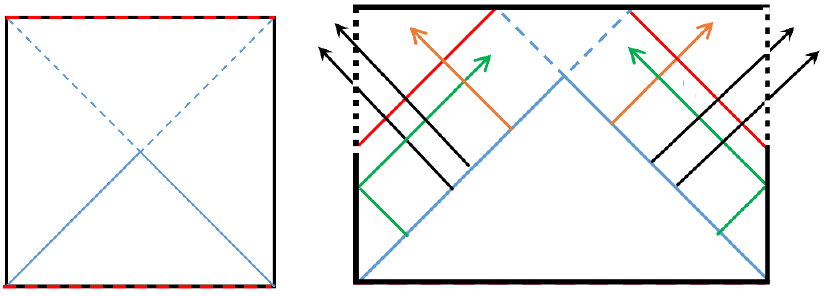
Figure 10 . (Left) For an eternal black hole dual to the thermo(cid:12)eld double state, the segments of the horizons to the past of the bifurcation surface (solid lines) join to form a mostly-null Cauchy surface. Data in this quantum state then propagates outward to the right and left. (Right) Turning on a coupling allows some modes from the above Cauchy surface to escape. But those that reach the boundary before the coupling is turned on are re(cid:13)ected back into the singularity, and modes close to the original bifurcation surface are focused by an incoming pulse of positive energy (red lines without arrows) associated with turning the coupling on. As a result of this focussing, semiclassical physics sates that such modes also fail to